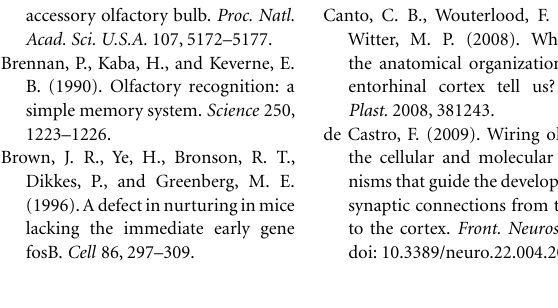
many genes tended to follow trends in expression in the immediate postpartum period, generally showing either a decrease or an increase in expression in most regions, rather than having variable changes. Note, genes were determined to have no change in expression if the mean fell between 0.9 and 1.1 (i.e., observed changes were less than 10% of virgin